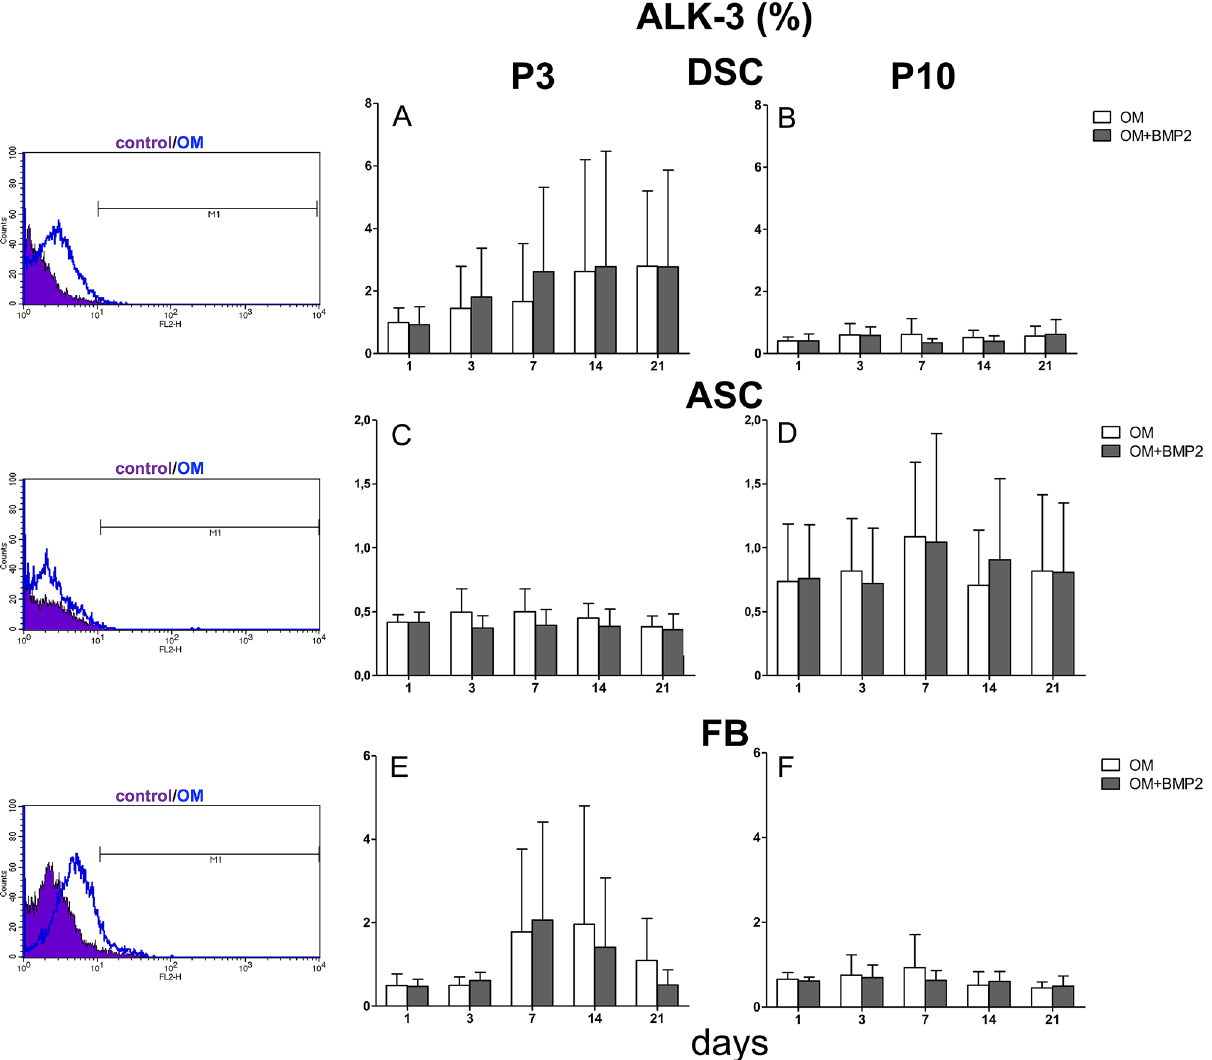
Figure 3. ALK-3 expression in P3 versus culture senescence cells at P10. ( A ) Evaluated was the ALK-3 expression in DSC at P3. Expression of ALK-3 increased over the course of osteogenic differentiation. ( B ) Evaluated was the ALK-3 expression in DSC at P10. The ALK-3 was expressed at a small amount at P10. ( C ) Evaluated was the ALK-3 expression in ASC at P3. ( D ) Evaluated was the ALK-3 expression in ASC at P10. ALK-3 showed a minor expression. ( E ) Evaluated was the ALK-3 expression in FB at P3. The expression increased slightly on day 7 and 14, but decreased again at day 21. ( F ) Evaluated was the ALK-3 expression in FB at P10. Grey bars represent these cells incubated with osteogenic differentiation media supplemented with BMP- 2. White bars represent cells differentiated with standard osteogenic differentiation media (OM). Bars represent mean ± SD of three